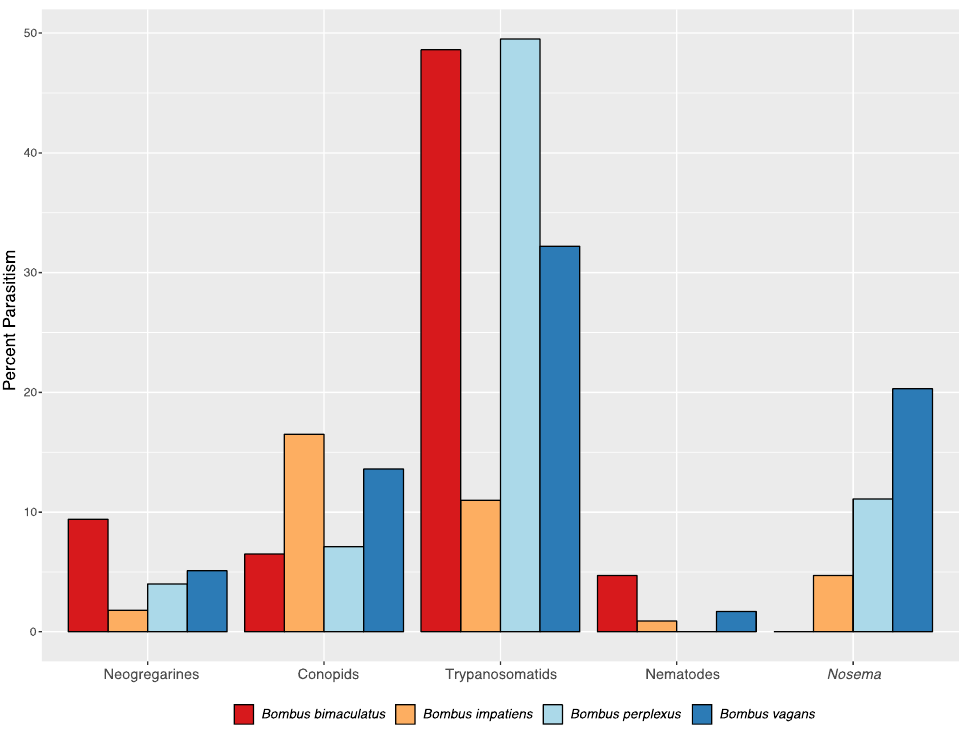
Figure 2. Percent infection of focal Bombus species workers by different parasite groups. Table 2. For each species, the numbers of workers and males collected (caste) during our surveys, including the percent of individuals infected with parasites. The prevalence of intense infections is shown in parentheses. S pecies